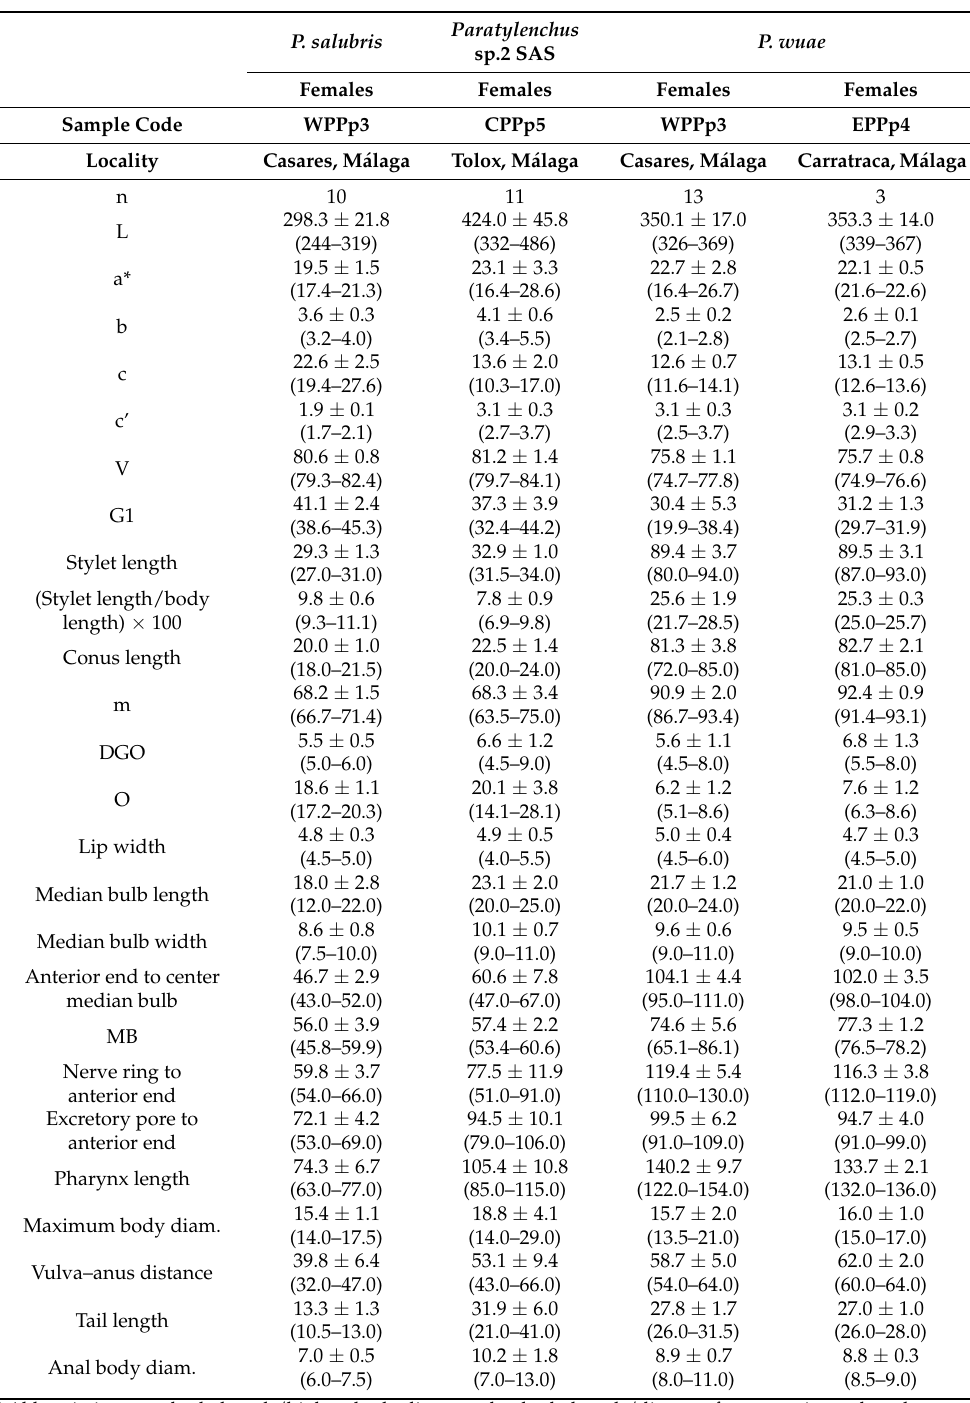
Table 6. Morphometrics of Paratylenchus salubris Raski, 1975, Paratylenchus sp. 2 SAS and Paratylenchus wuae Yu, Ye & Powers, 2016 females. All measurements are in µ m and in the form: mean ± s.d.